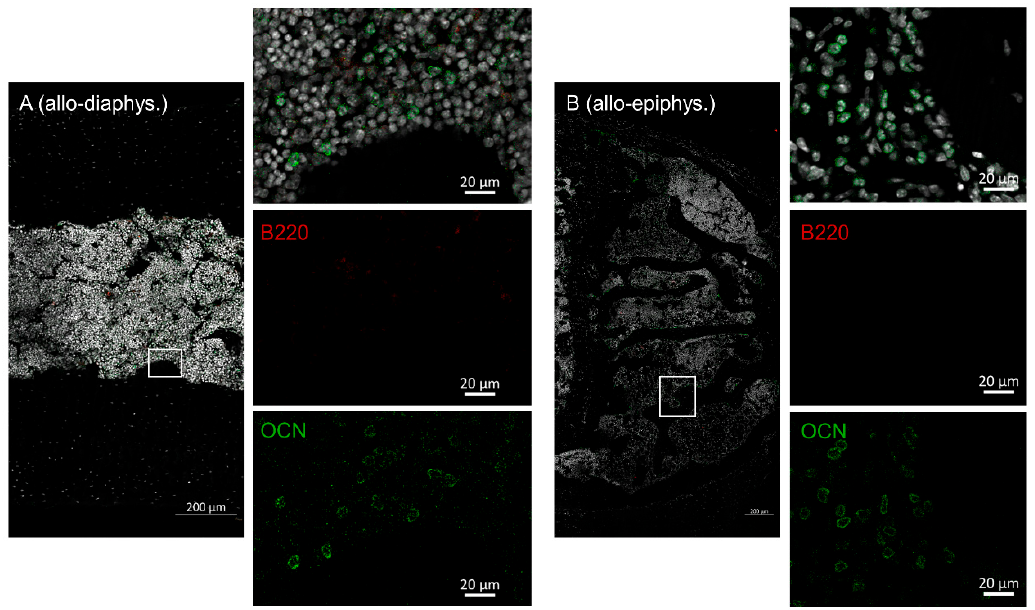
Figure 5. Femora harvested at day +20 after allo-HSCT were prepared for immunohistochemistry (N = 6). Within the diaphysis of the femora (( A ) allo-diaphys.) no osteocalcin positive lining cells were detected within the endosteal region and B cells were absent from the BM cavity. Of note, osteoblasts were found evenly distributed throughout the BM space. The same result was true for the epiphyseal bone (( B ) allo-epiphys.). Nuclei (Dapi = white, 2nd outtake image from top to bottom), B cells (B220 = red, single stain 3rd outtake image from top to bottom), osteoblasts (osteocalcin = green, single stain 4th outtake image from top to bottom). Representative images are